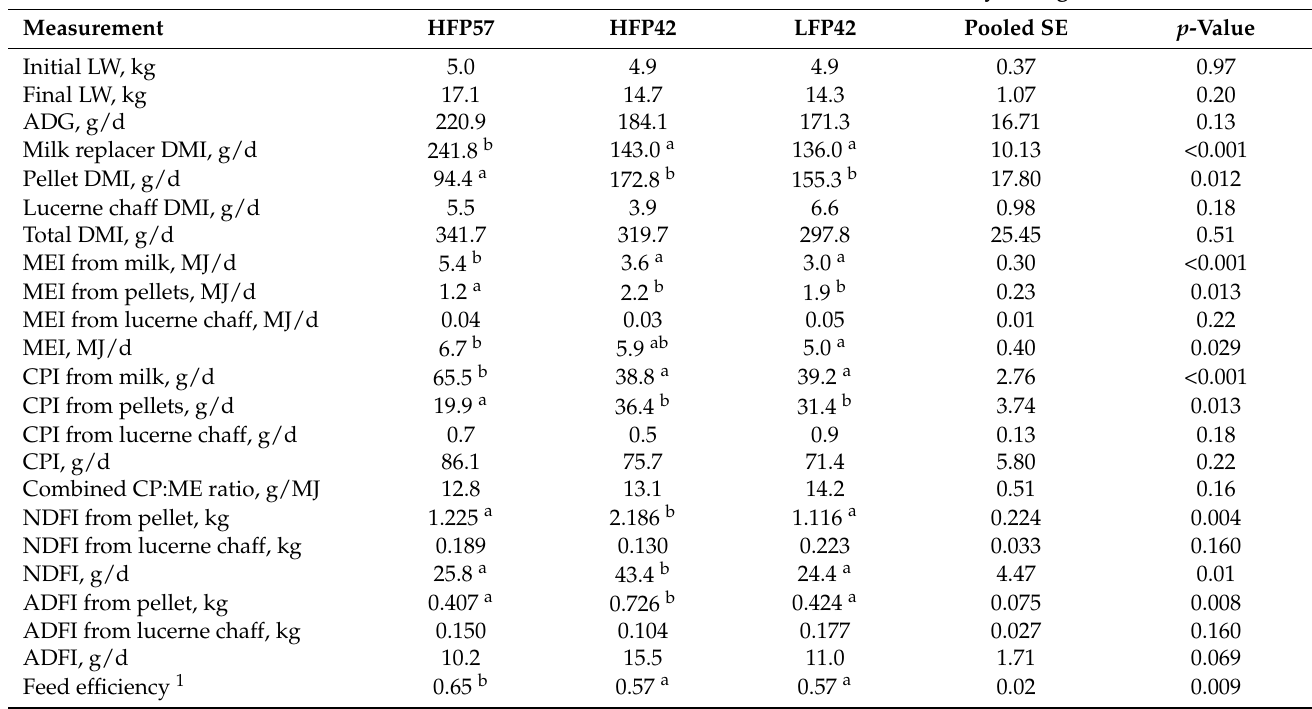
Table 4. Overall intake and growth performance of lambs reared artificially (2–57 days of age) using three different rearing regimens: HFP57, commercial milk replacer, high fibre concentrate pellets and milk feeding to 57 days of age; HFP42, commercial milk replacer, high fibre concentrate pellets and early weaning at 42 days of age; LFP42, high protein milk replacer from 2–16 days of age followed by commercial milk replacer, low fibre concentrate pellets, and early weaning at 42 days of